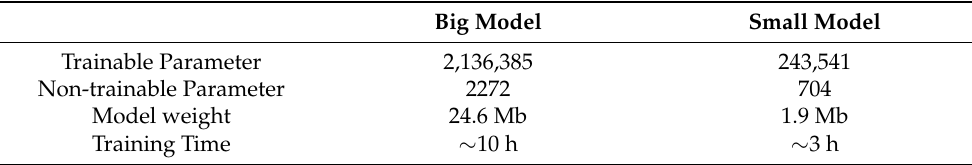
Table 8. Performances comparison considering the big and the small models. Big Model Small Model